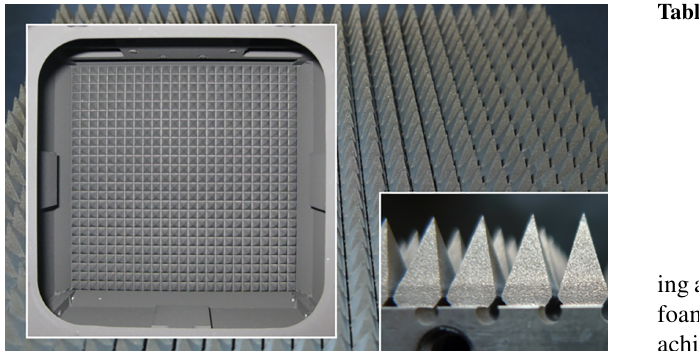
Table 2. Properties of the PCM cooling pads